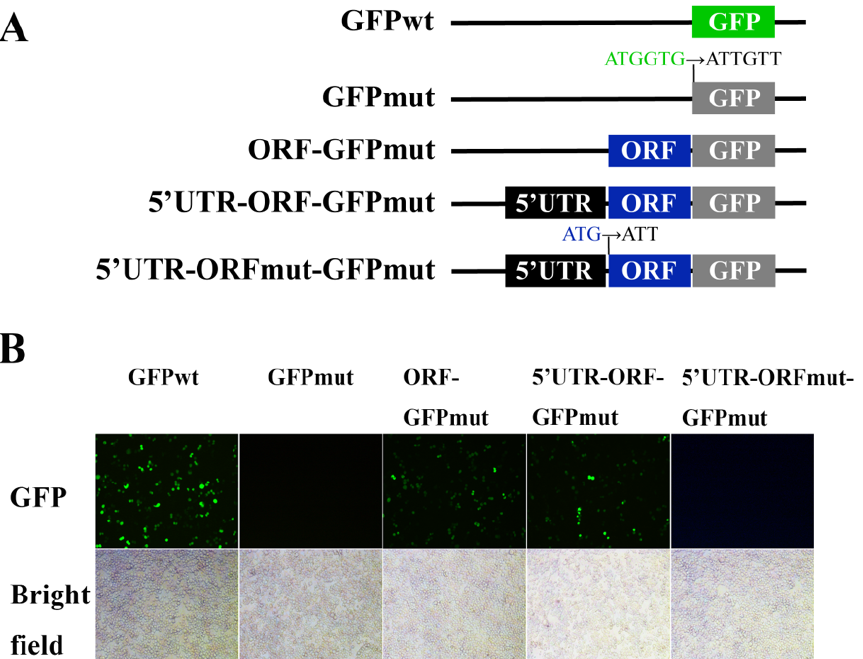
Figure 2. Encoding capability of start codon in the predicted ORF in LvHSSP transcript. ( A ) Diagram of the GFP fusion constructs used for transfection. The start codon ATGGTG of the GFP (GFPwt) gene is mutated to ATTGTT (GFPmut). The start codon ATG of the ORF in LvHSSP transcript is mutated to ATT. ( B ) GFP fluorescence signals in different constructs of transfected Sf9 cells. To investigate whether LvHSSP encoded a secretory protein, the mutant nucleotide sequence encoding the signal peptide and wild-type ORF of LvHSSP were fused to the N terminus of GFP, respectively. The bands of LvHSSP-GFP fusion protein were observed in the serum and whole cell lysis of LvHSSP WT -GFP-transfected Sf9 cells. However, the bands could be observed in the whole cell lysis of LvHSSP SPmut -GFP-transfected Sf9 cells, but nearly undetectable in the corresponding serum compared to that in the serum of LvHSSP WT -GFP-transfected Sf9 cells (Figure 3).